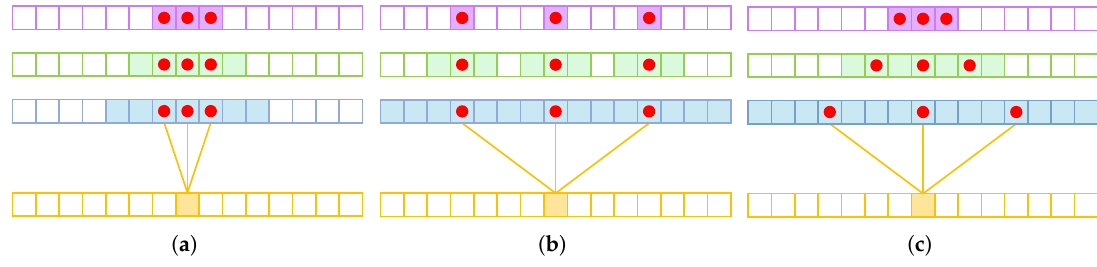
Figure 4. The receiving fields of the 3rd layer in the different convolutional block (in the case of one-dimension). ( a ) The receptive field (densely naive convolutional block). ( b ) The receptive field (densely naive dilated convolutional block). ( c ) The receptive field (densely pyramidal dilated convolutional